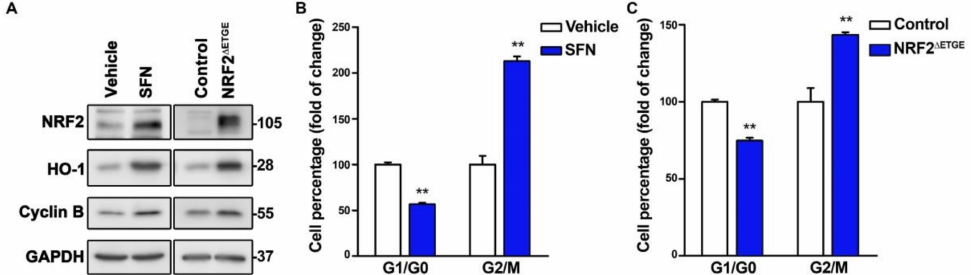
Figure 2. NRF2 activation propels the proliferation rate. U–373 MG glioblastomas cells were treated with vehicle or 10 µ M SFN for 16 h, or transduced with a lentiviral vector expressing mutant NRF2 ∆ ETGE or empty vector (Control). ( A ) Representative immunoblot analysis of NRF2, HO–1, Cyclin B, and GAPDH as a loading control; ( B , C ) Flow cytometry analysis of G1/G0, and G2/M cell distribution in Hoechst–stained cells. Data are presented as mean ± S.D. ** p ≤ 0.01 according to a Student’s t -test ( n =